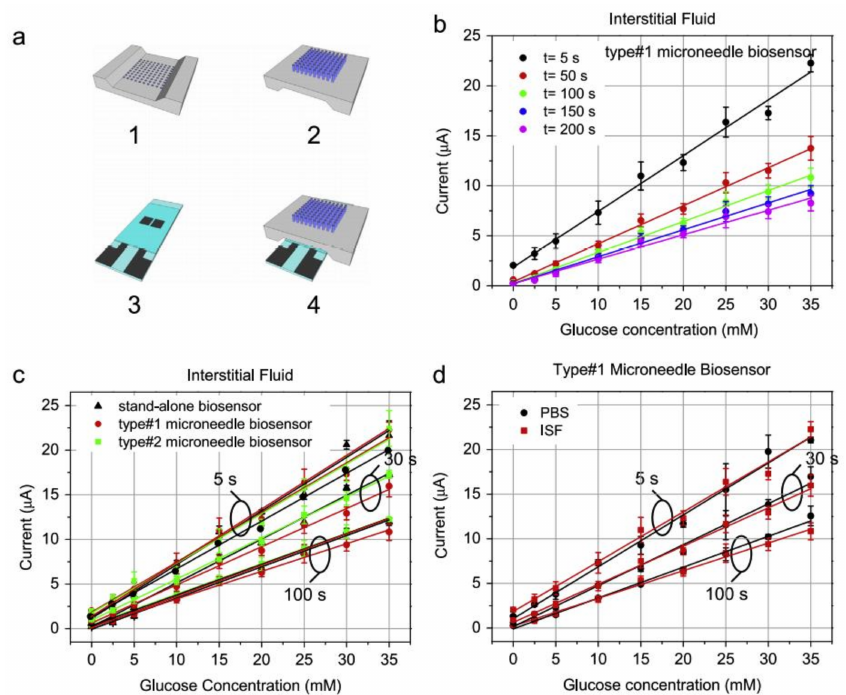
Figure 1. ( a ) Representation of the biosensor having glucose sensor attached on the back of the microneedle; ( b ) Calibration curves for the concentration between 0–35 mM; ( c ) Calibration curves of developed biosensors and stand-alone biosensors in ISF, and ( d ) Calibration curves for developed biosensor for concentration 0–35 mM at 5 s, 30 s, and 100 s of sampling times. Reproduced from Reference [20] with permission. Copyright 2015,